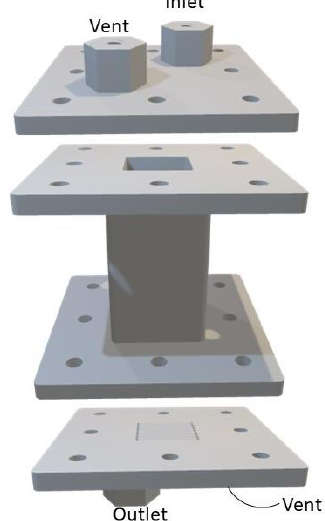
Figure 2. Different components of a z 2 cuboid SEC device.